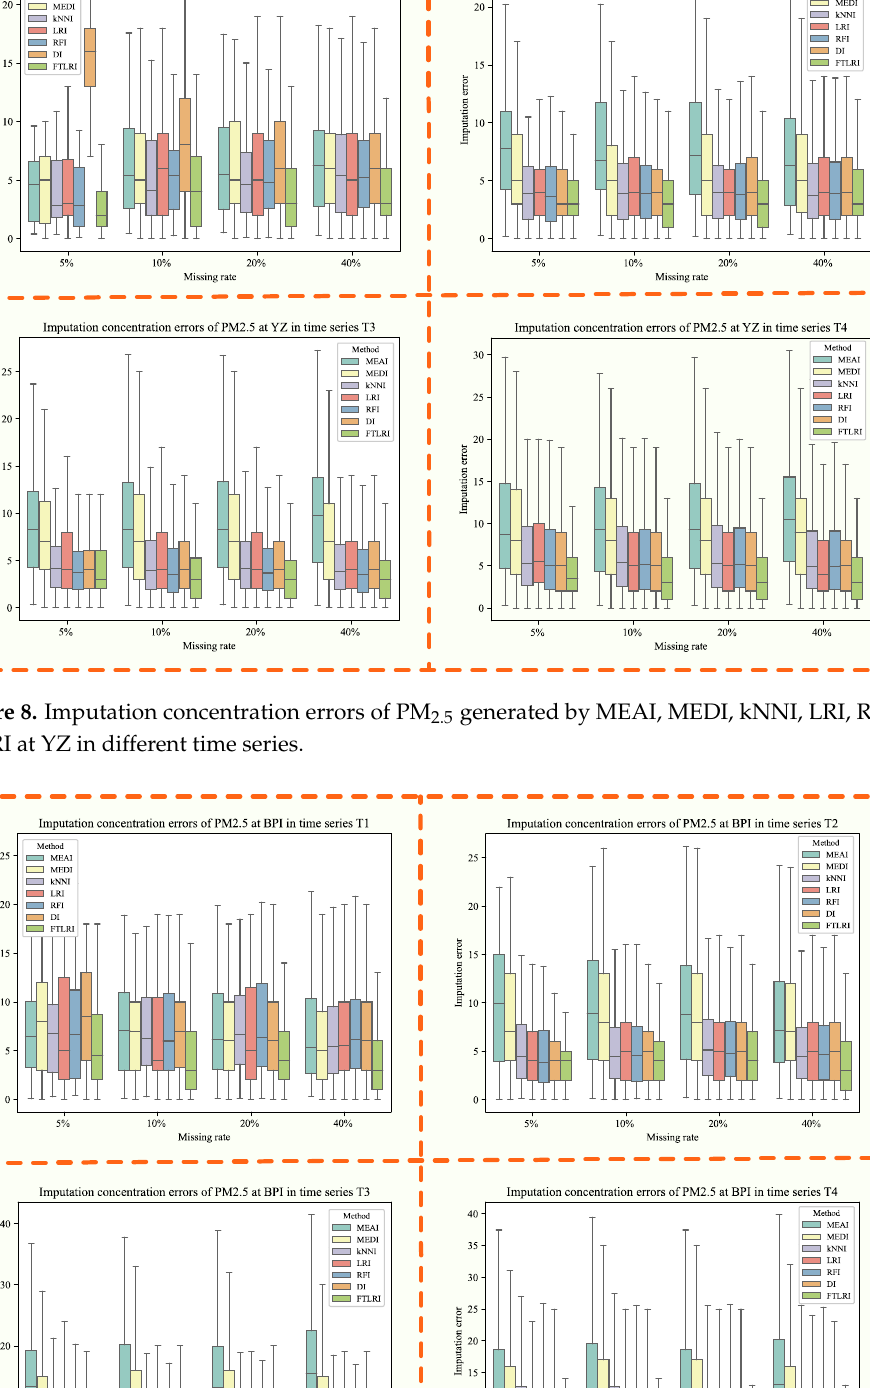
Figure 7. Imputation concentration errors of PM 2.5 generated by MEAI, MEDI, kNNI, LRI, RFI, DI, FTLRI at LH in different time series.